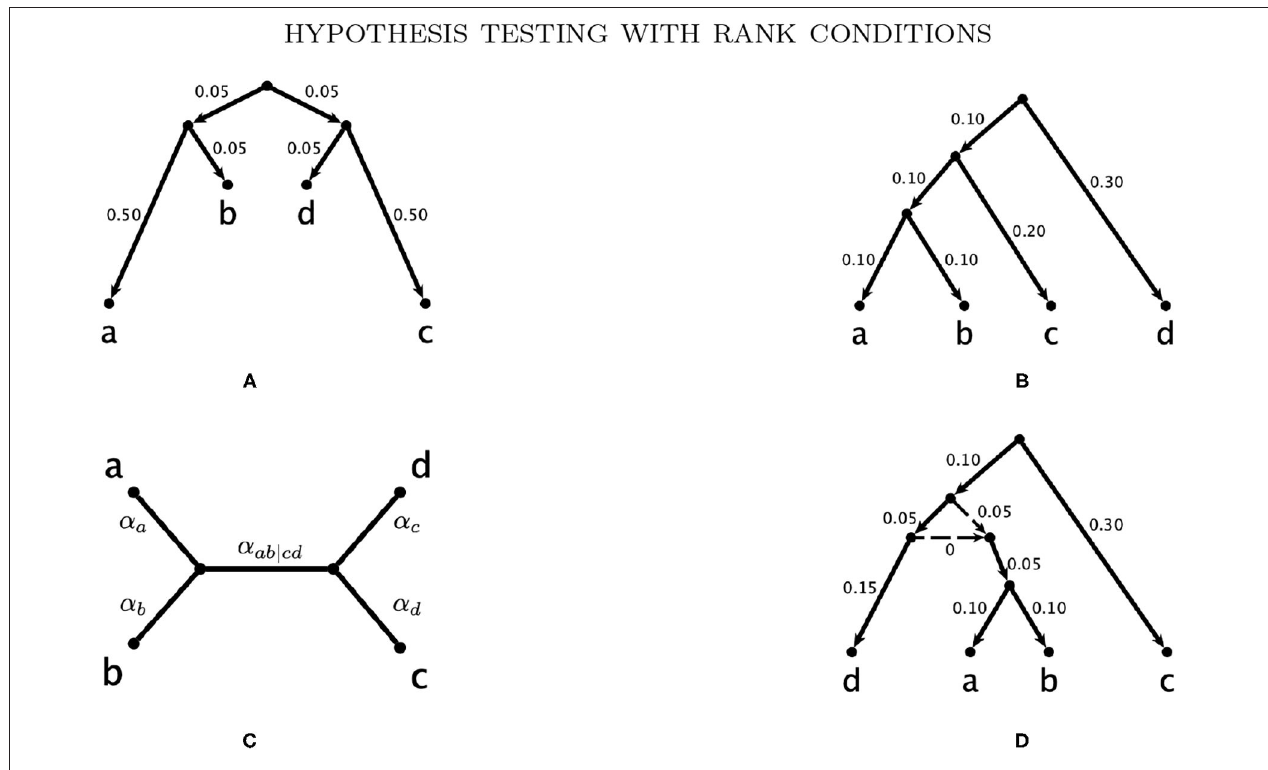
FIGURE 3 | The trees and network used to simulate gene level phylogenies. (A) Tree A ., (B) Tree B ., (C) Tree C ., and (D) The network N with tree clade ab